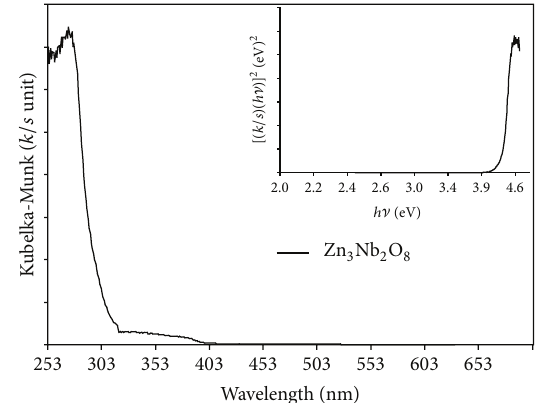
Figure 4: The room temperature PL spectra (excitation at 284 nm and emission at 465 nm) of the synthesized nanomaterial Zn 3 Nb 2 O 8